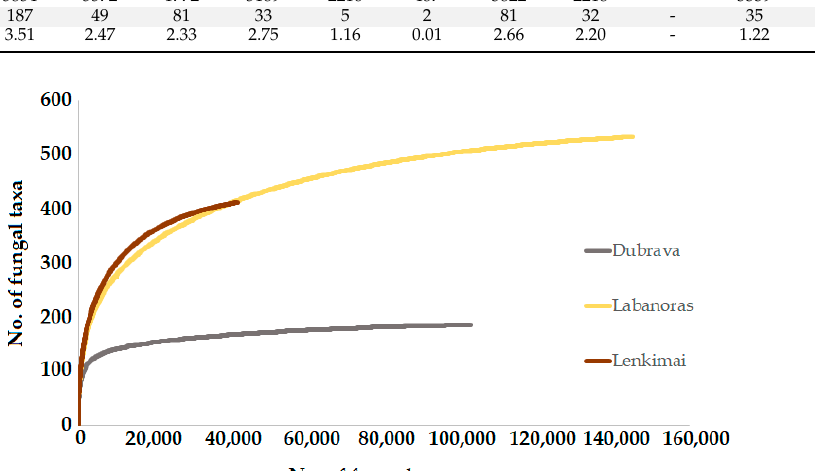
Figure 3. Rarefaction curves showing the relationship between the cumulative number of fungal taxa and the number of ITS2 rRNA sequences from three sampling sites.